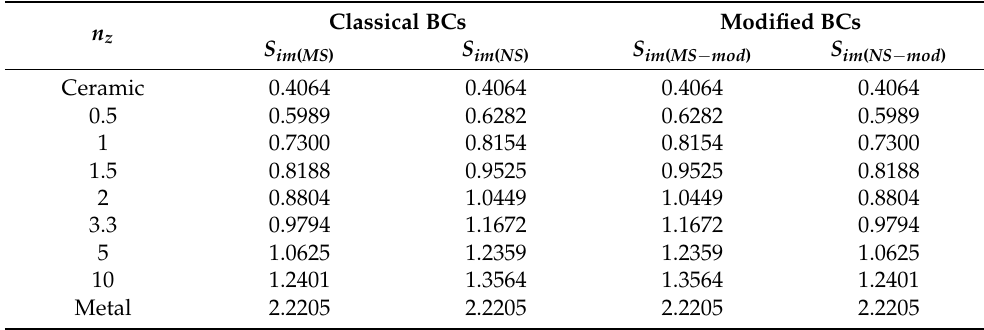
Figure 8. Solutions generated by ( a ) S im ( MS − mod ) : MS formulation using the modified BCs (Equation (28)) and ( b ) S im ( NS − mod ) : NS formulation applying modified BCs (Equation (29)) for an immovable simply supported square plate ( a / h = 100, n z = 0.5 ) . Table 8. Non-dimensional deflection w of an Al / Al 2 O 3 square immovable simply supported plate under uniform load based on the middle surface formulation S im ( MS ) and the neutral surface formulation S im ( NS ) , subjected to classical and modified ( mod ) BCs ( a / h = 100 , n x = 0 )